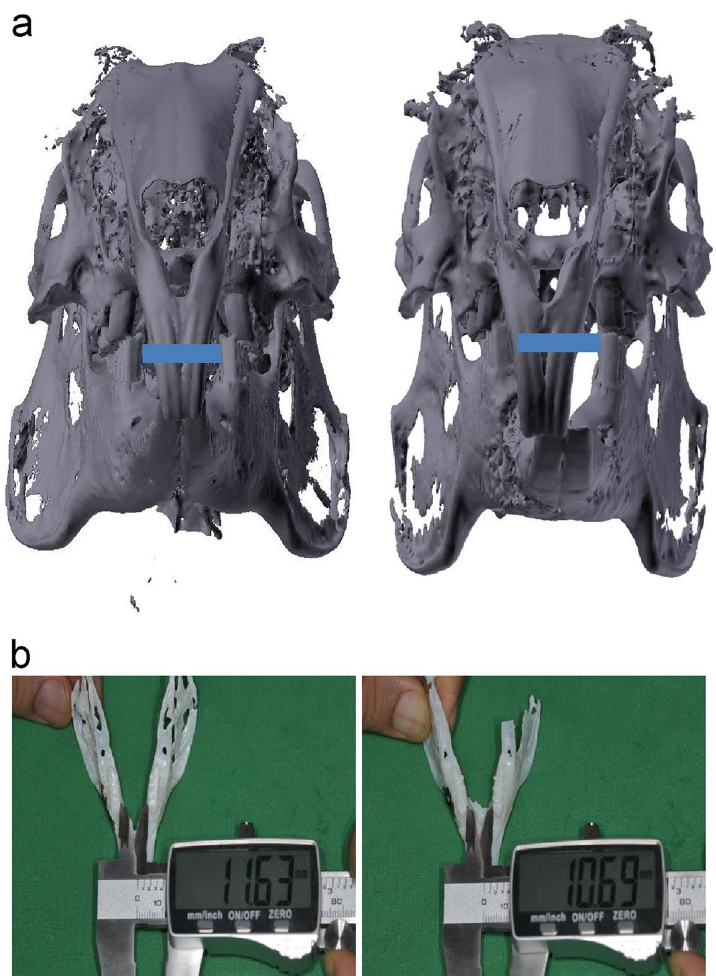
Fig. 6 Measurement of the mandibular width. a The distance between the lingual cusps of the first mandibular molars in the three-dimensional (3D) output model constructed preoperatively (blue line); b the distance between the lingual cusps of the first mandibular molars in the 3D output